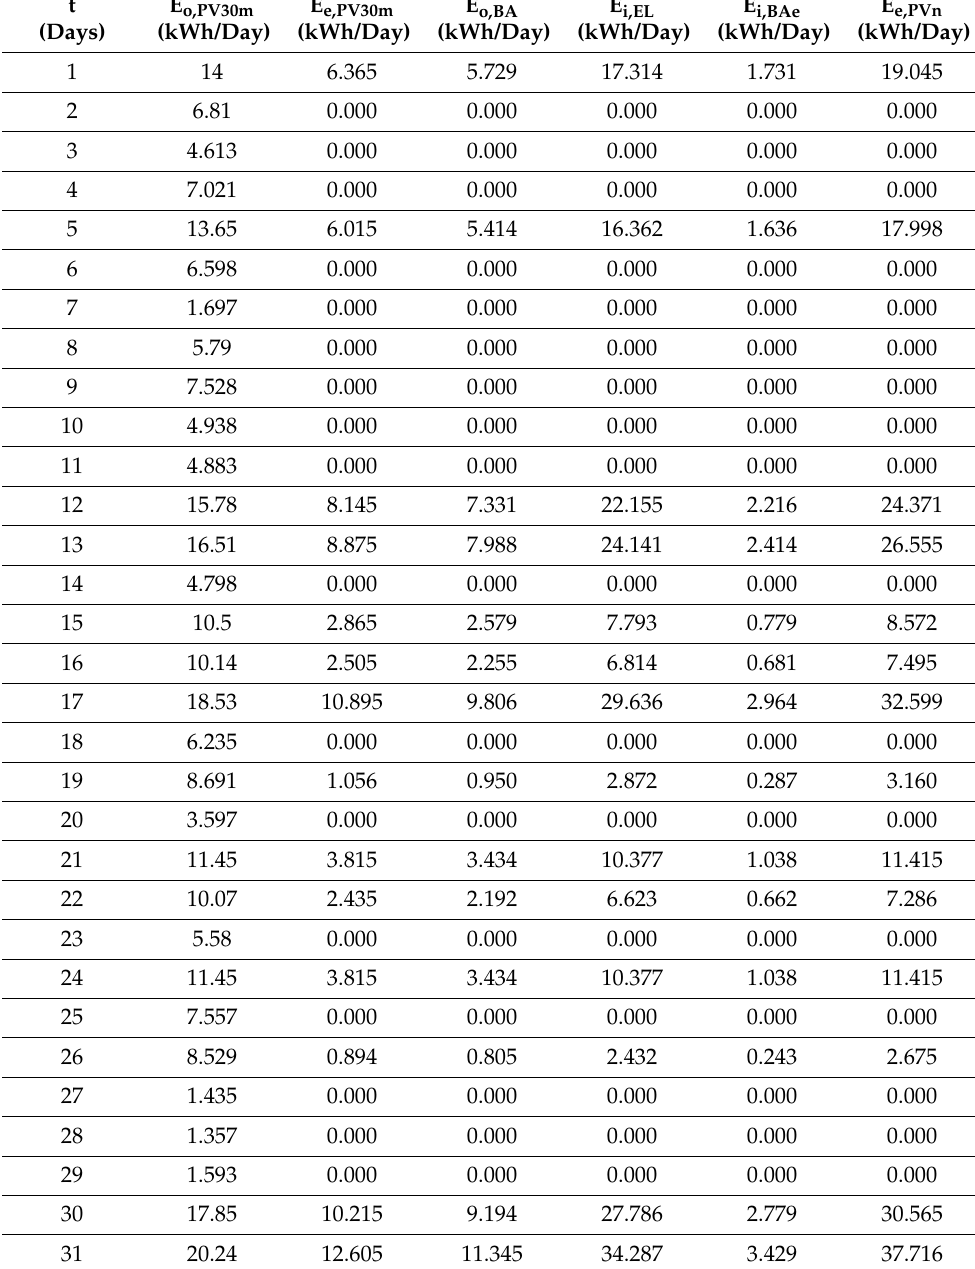
Table 1. Photovoltaic panel energy, battery energy, and electrolyzer